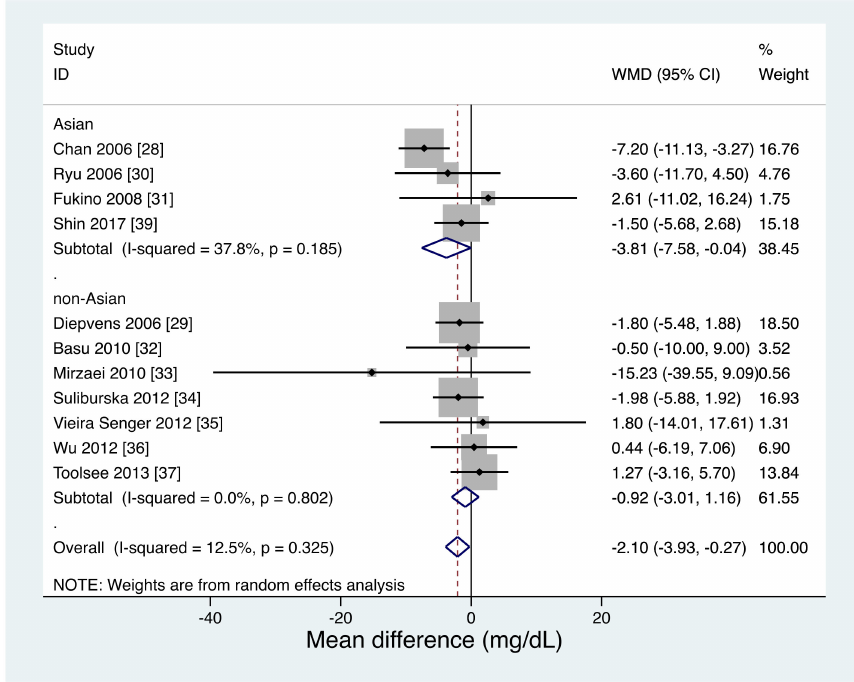
Figure 5. Direct pairwise meta-analysis: effects of green tea on fasting blood glucose levels stratified by Asian-based studies and non-Asian based